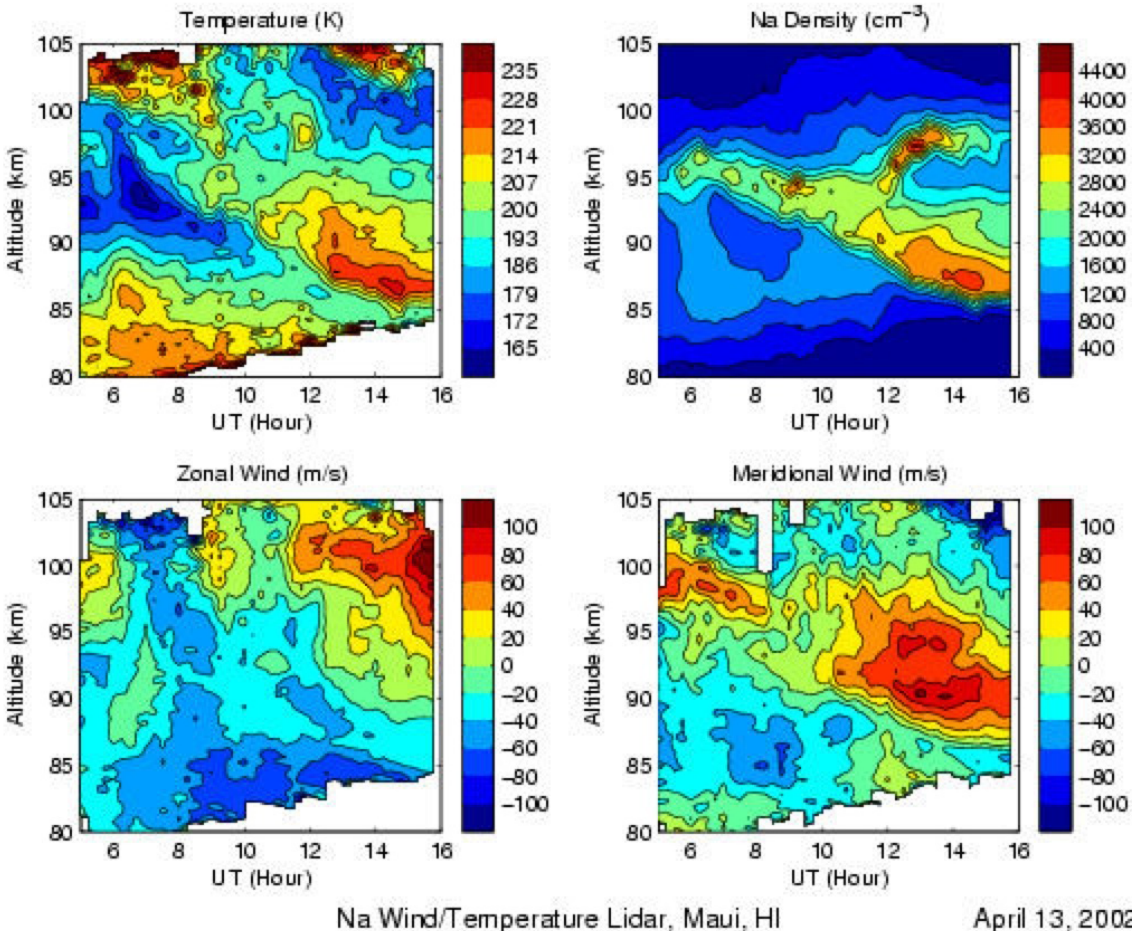
Fig. 1. Contour plots as a function of time and altitude of the temperature, sodium density, zonal winds, and meridional winds measured with the Maui/MALT lidar on 13 April